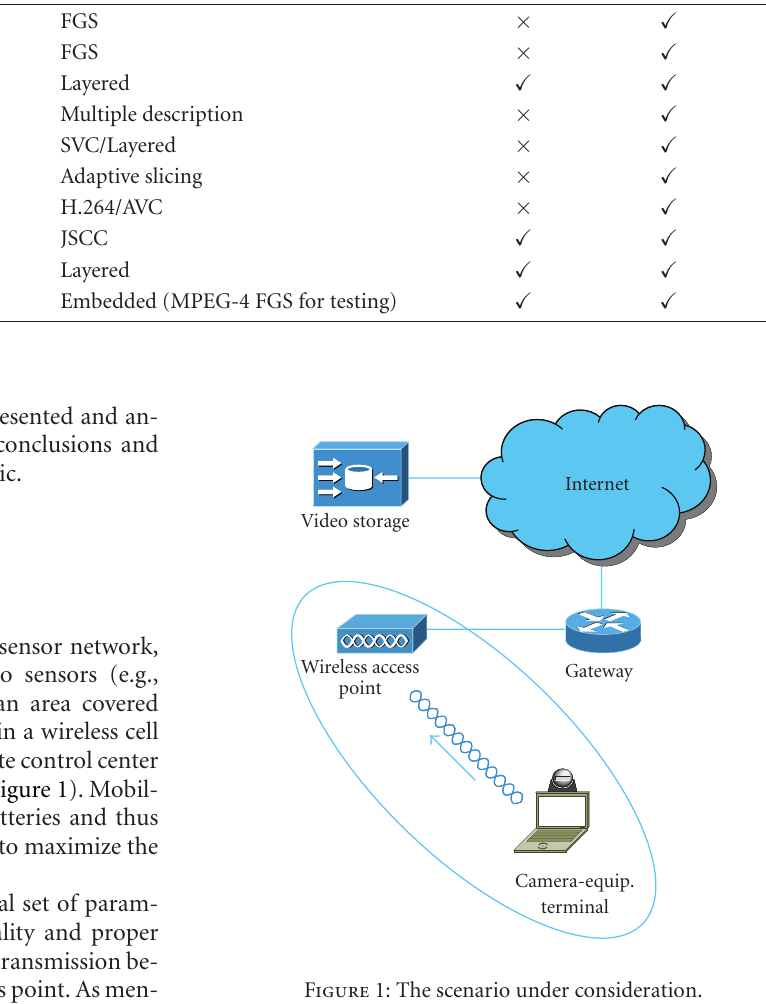
Table 1: Comparison among relevant state-of-the-art approaches and the work presented in the paper. Rate-distortion model